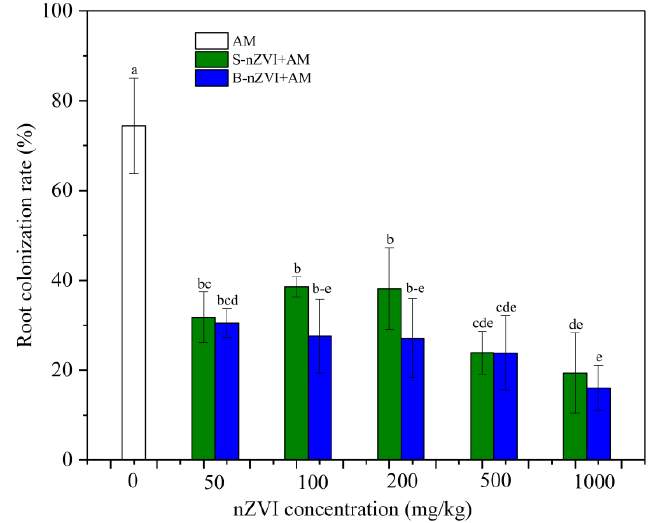
Figure 1. Root mycorrhizal colonization of sweet sorghum plants. Note: AM represents inoculation with A. mellea ZZ; S-nZVI+AM represents the treatments that received S-nZVI and AM inoculation; B-nZVI+AM represents the treatments that received B-nZVI and AM inoculation. Different letters above the bars indicate significant differences ( p < 0.05). Two-way ANOVA results are shown in Table 2. Table 2. Significance levels ( F values) of AM inoculation, nZVI type and concentration, and their interactions on measured parameters on a three-way ANOVA analysis. nZVI Conc. AM × Conc. AM × Type ×